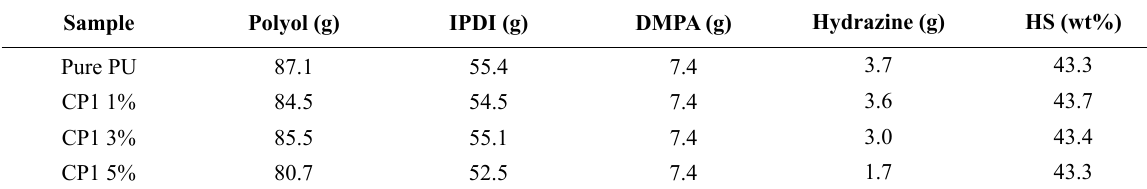
Reactants amounts and calculated hard segments (HS) for pure PU and the composites prepared by in situ polymerization (CP1).